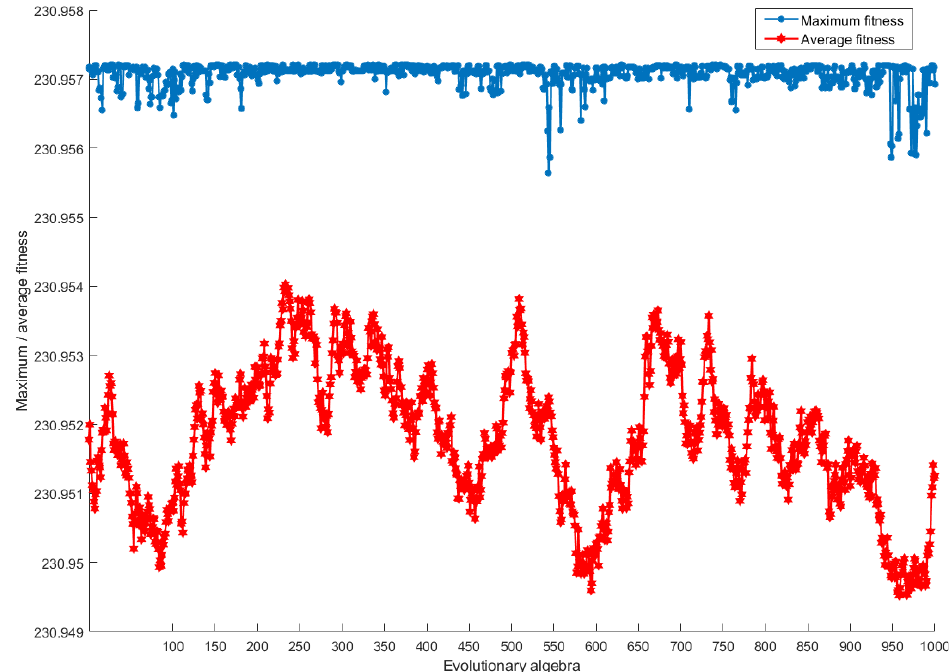
Figure 6. Schematic diagram of maximum/average fitness curve law.